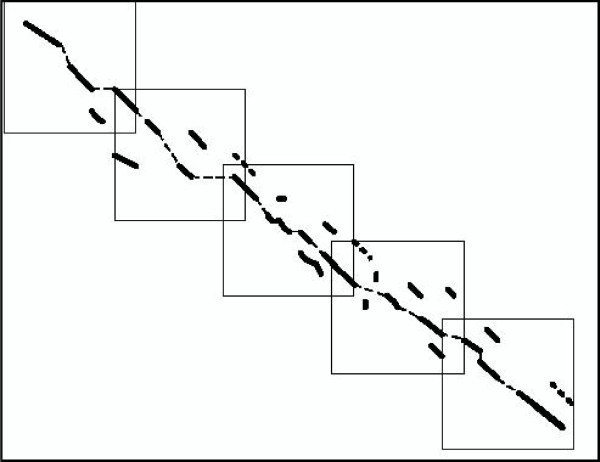
Derivation of blocks in which to search for HSPs. Blocks (dotted squares) are created along the maximum-weight chain (dashed thin lines) of gapped local alignments (thick black lines).